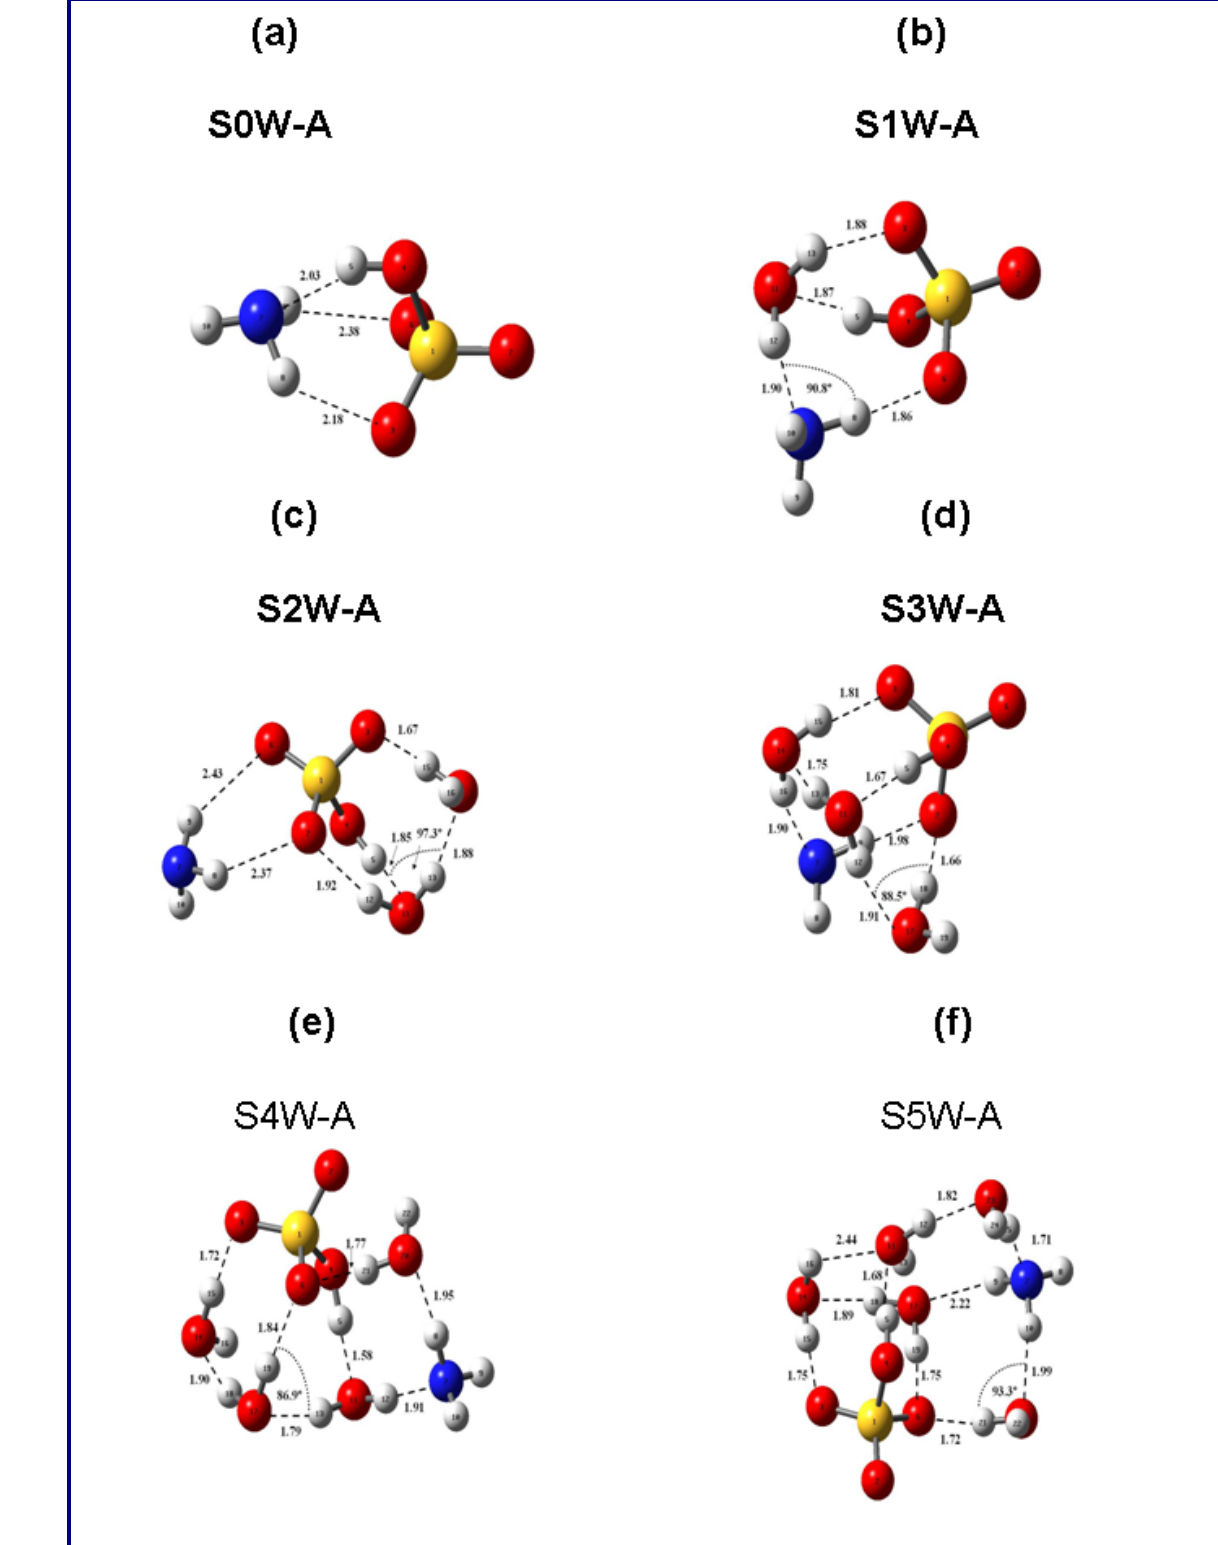
) (H O); 3 2 )(H O) ; 3 2 4